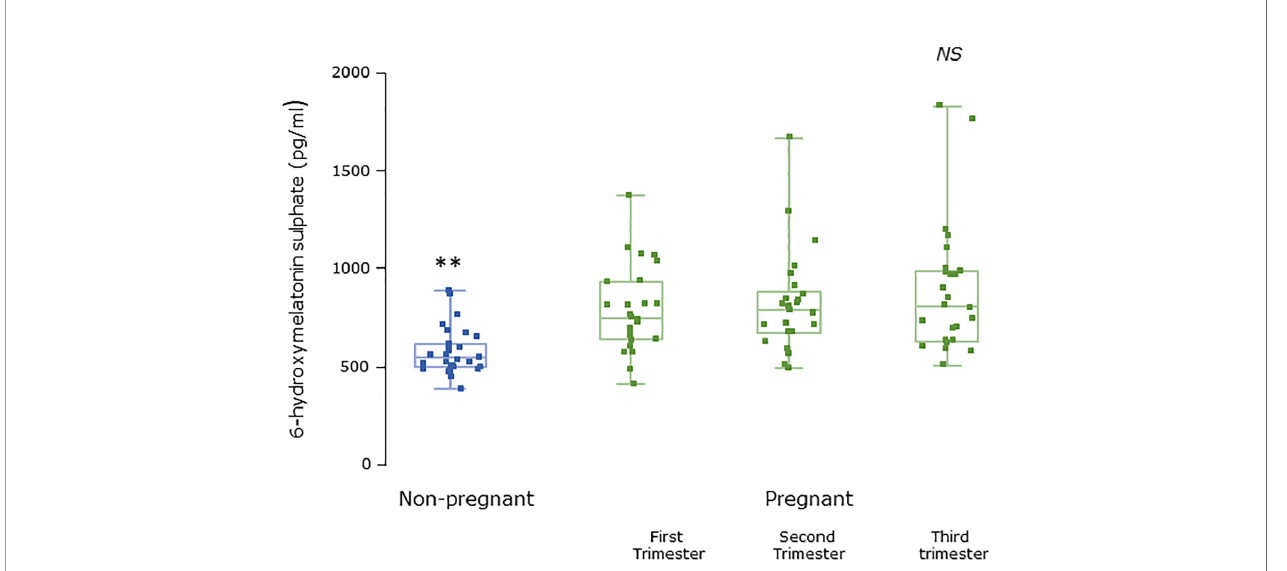
FIGURE 4 | Serum 6-hydroxymelatonin sulfate levels from MEL-P in non-pregnant healthy control subjects (n = 30) compared to pregnant subjects throughout pregnancy (n = 26). **, signi fi cantly different from pregnant women in the fi rst, second, and third trimesters (all P < 0.0001, Wilcoxon-Mann Whitney test). Data are shown as median, interquartile, and full range. NS, non signi fi